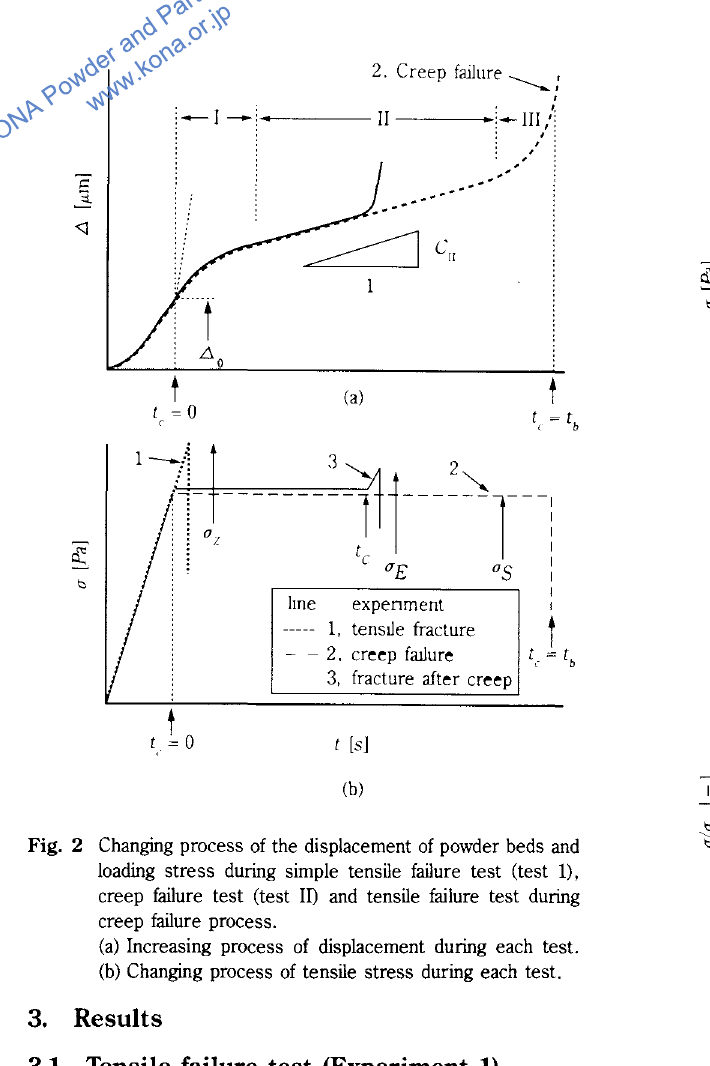
Fig. 2 Changing process of the displacement of powder beds and loading stress during simple tensile failure test (test 1), creep failure test (test ID and tensile failure test during creep failure process.